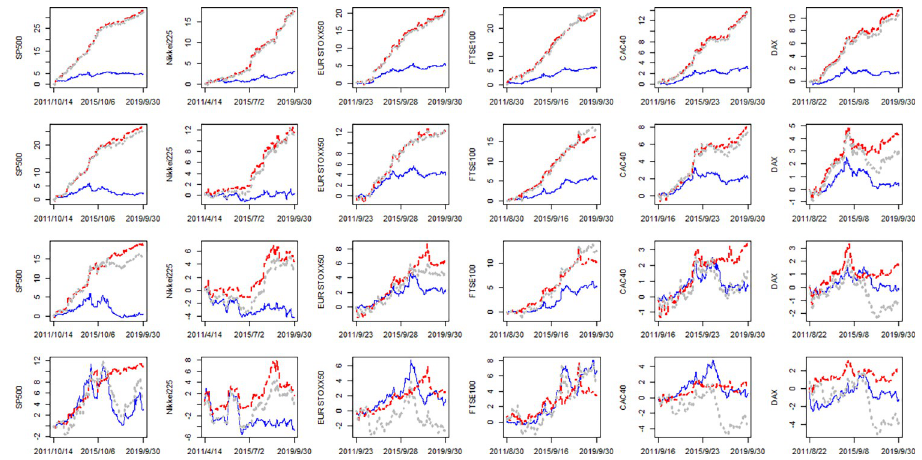
Fig 3. The cumSFE of LHARO, LHARV and LHAROV relative to LHAR (rolling window). Notes:The first, second, third and fourth row corresponding to h = 1,5,10,22, respectively. The blue line, red line and gray line denotes the cumSFE( LHARO , N ), cumSFE( LHARV , N ) and cumSFE( LHAROV , N ), respectively.